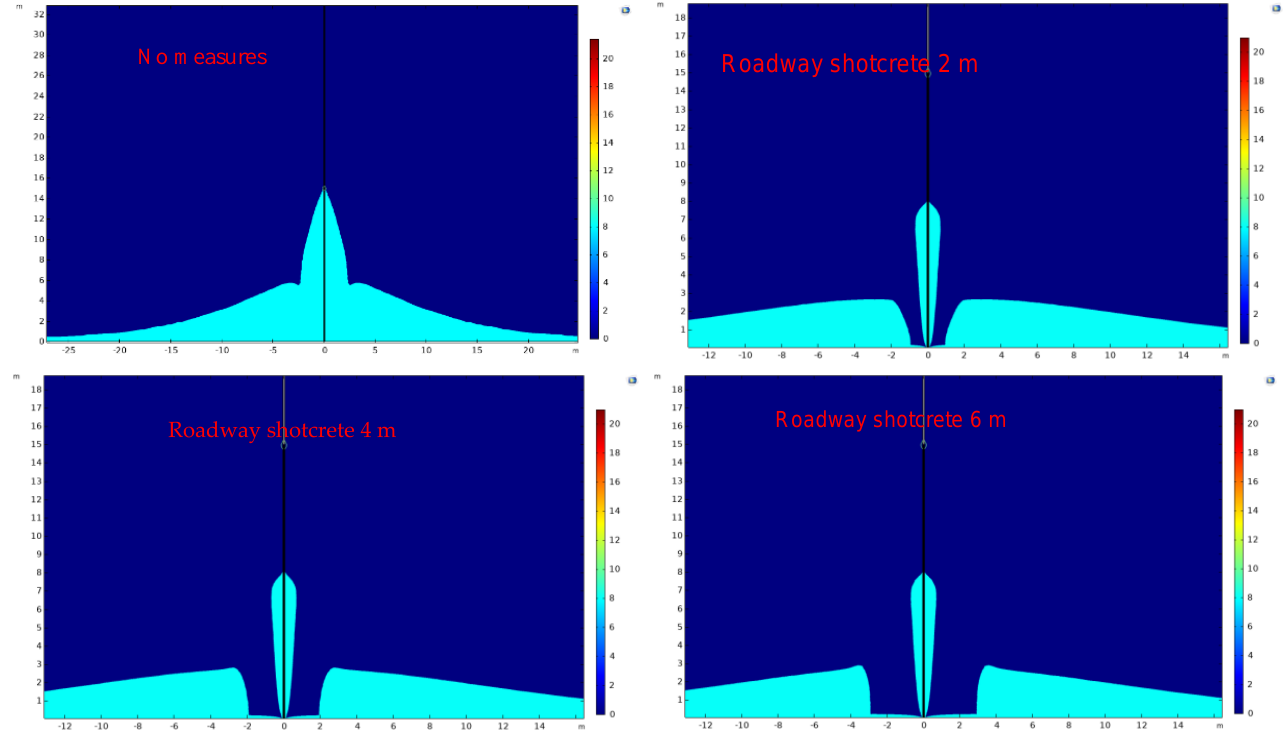
Figure 4. The cloud map of oxygen concentration for different roadway grouting lengths was obtained.